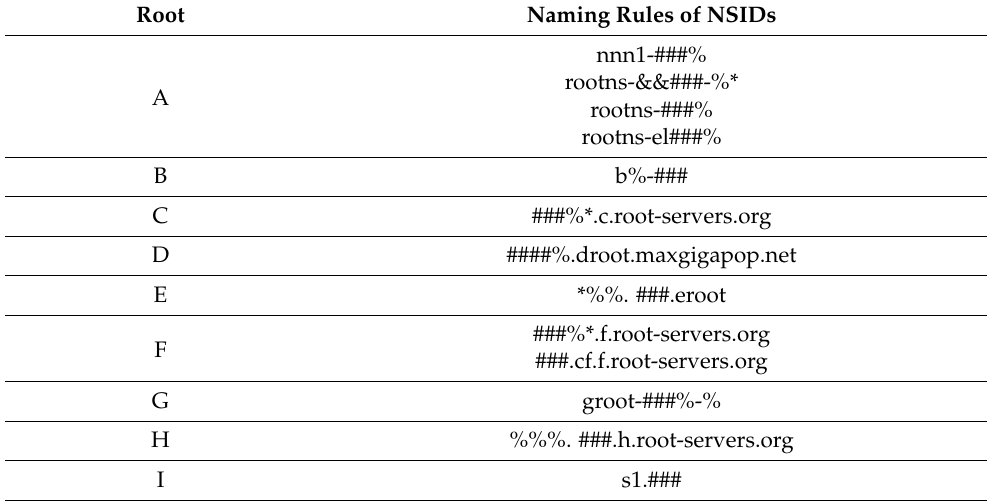
Table 2. Naming rules of different root’s NSIDs.